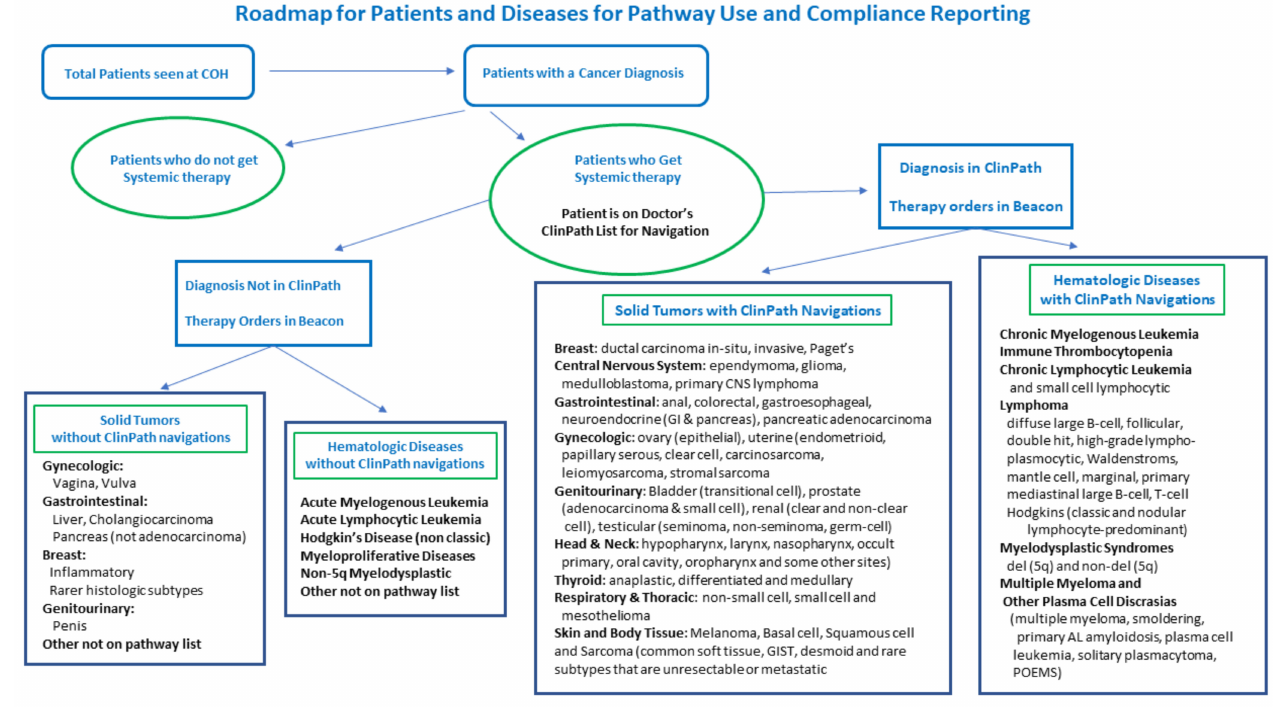
Figure 4. Roadmap of patients seen at City of Hope to understand those with diseases eligible for pathway use and reporting from ClinPath system. Both patients with and without a diagnosis in the ClinPath system will have Beacon therapy orders in the EHR. GI (gastrointestinal), CNS (central nervous system), GIST (gastro intestinal stromal tumor). Table 1. Therapy Decisions from ClinPath Tool for Solid Tumors and Hematology by Enterprise, Duarte, and Network Sites. Pathway Compliance for Enterprise (E), Duarte Academic Campus (D), and Network (N) Clinician ClinPath Navigations over 3 years, 2019–2021. Total Number of Decisions On and Off-Pathway; total number of On-pathway Decisions for Enterprise, Duarte, and Network Sites; and total percent of On-pathway Navigations for Enterprise, Duarte, and Network sites. From ClinPath